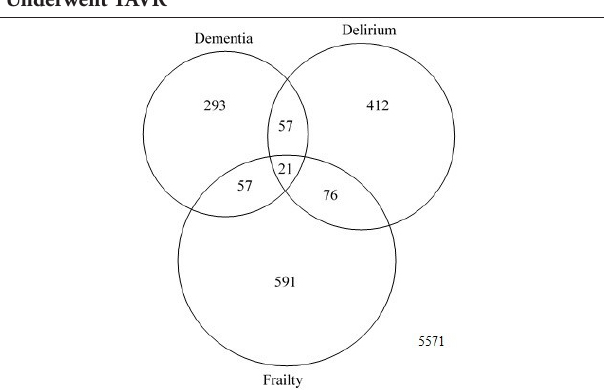
Figure 1. Number of Patients with Geriatric Syndromes